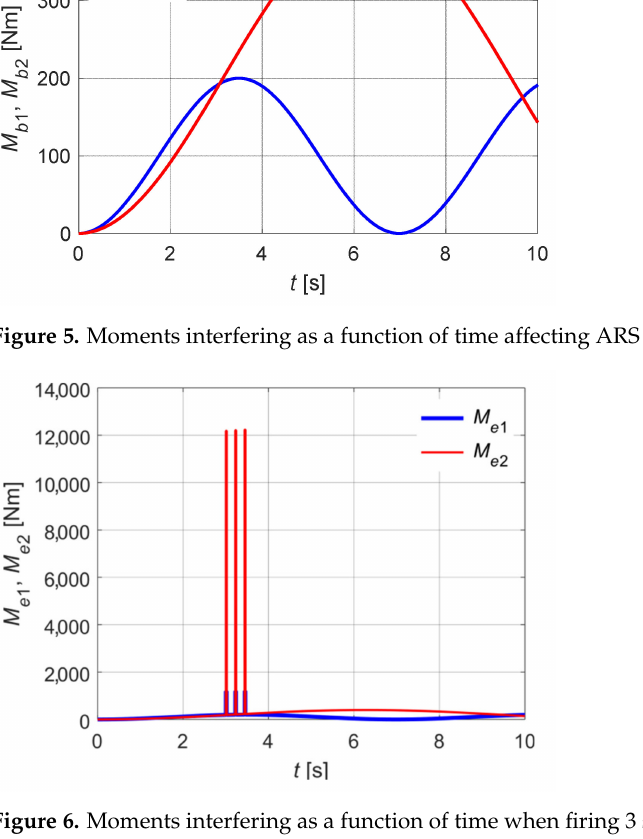
Figure 6. Moments interfering as a function of time when firing 3 shots affecting ARS.